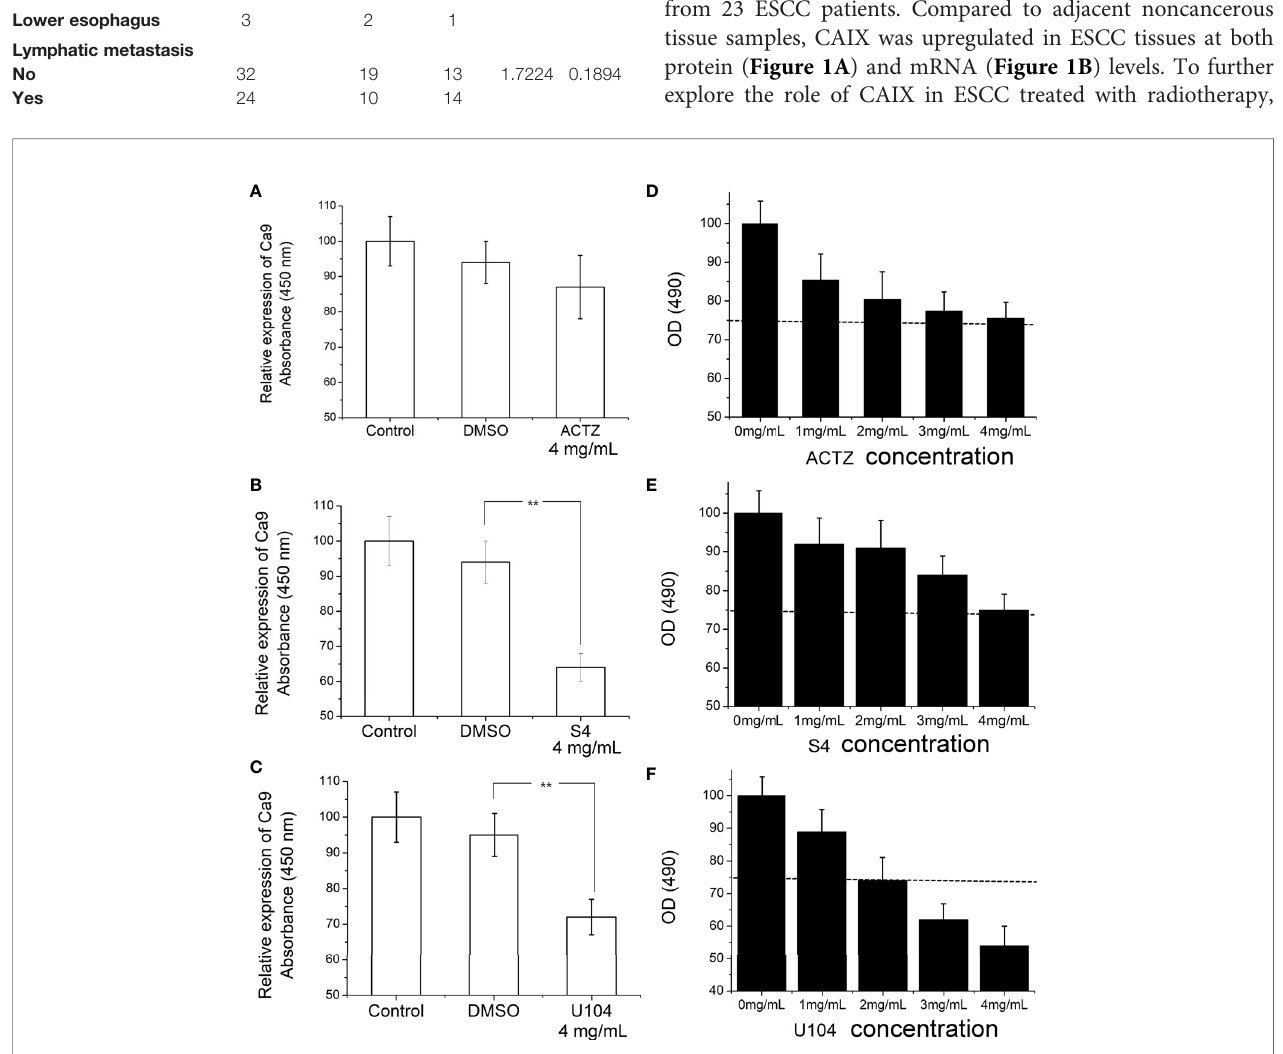
FIGURE 2 | Effect of ACTZ, S4, and U104 treatment on CAIX expression and cell viability in ECA-109 cells. ECA-109 cells were treated with or without ACTZ (4 mg/ mL), S4 (4 mg/mL), U104 (4 mg/mL), or DMSO for 12 h under hypoxic conditions. (A – C) The expression of CAIX in each group of cells was measured by ELISA. (D – F) Cell viability results of ECA-109 cells treated with ACTZ, S4, U104 at various doses (0, 1, 2, 3, and 4 mg/mL) for 24 h. ** P < 0.01.